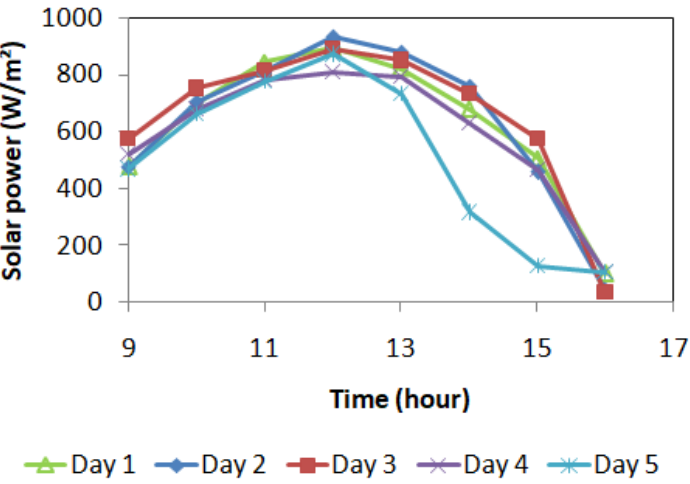
Figure 3. Solar power recorded for five days in June 2019.